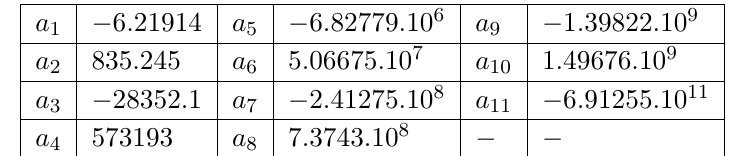
Table 7 . The coe(cid:14)cients a i for the (cid:12)t to the data from table 4 of ref.